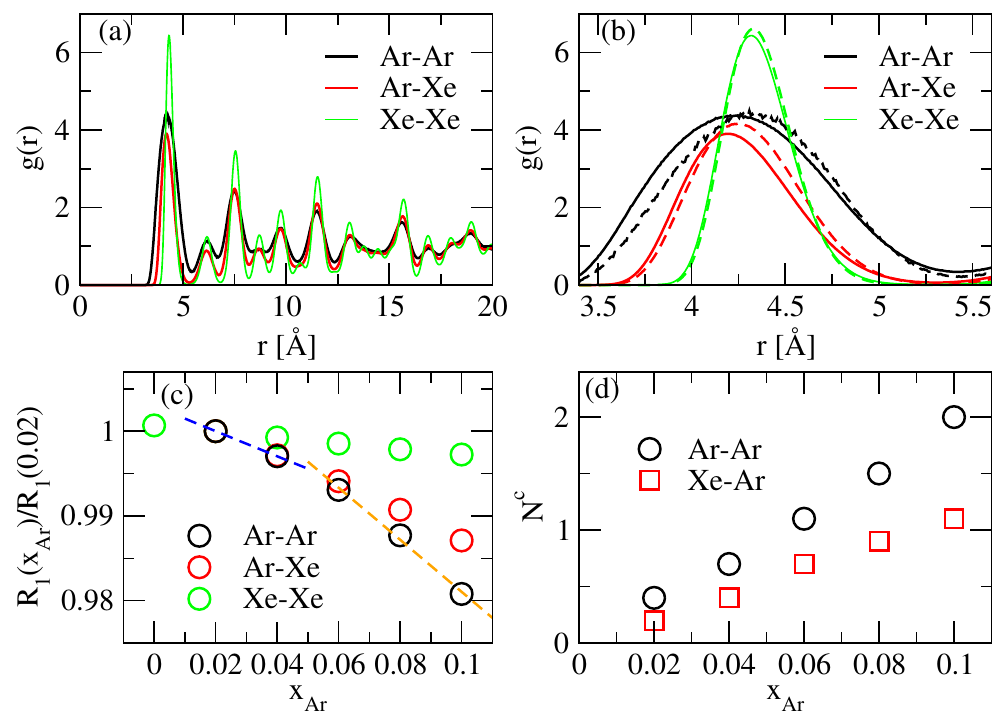
Figure 1. RDFs and information obtained from RDFs. ( a ) RDFs at T = 85 K and x Ar = 0.02. ( b ) RDFs enlarged around nearest neighbour distances at T = 85 K and x Ar = 0.02 (broken lines) or x Ar = 0.10 (solid lines). ( c ) Nearest neighbour distances ( R 1 ) normalised by their values at x Ar = 0.02. ( d ) The mean number of Ar nearest neighbours around an Ar atom (Ar-Ar) or a Xe atom (Xe-Ar). The cluster formation can also directly be seen in the snapshots of the MC simulation (Figure 2).